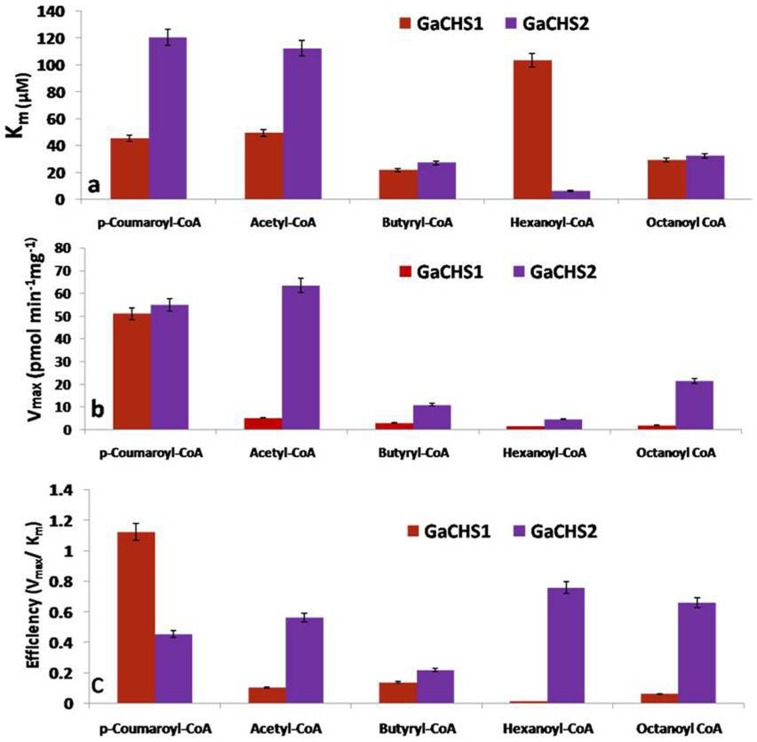
Kinetic study of GaCHSs using different substrates.The kinetic parameters Km and Vmax were calculated by nonlinear regression analysis in order to determine the relative efficiency of GaCHS1 and GaCHS2 against the different substrates including p-coumaroyl-CoA, Acetyl-CoA, Butyryl-CoA, Hexanoyl-CoA and Octanoyl CoA.